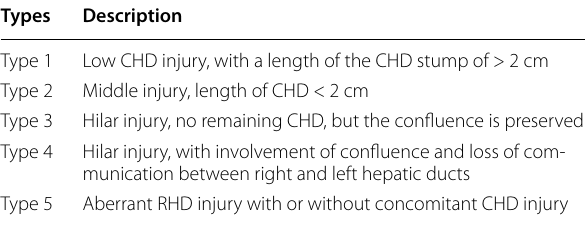
Table 1 Bismuth-Corlette classification system